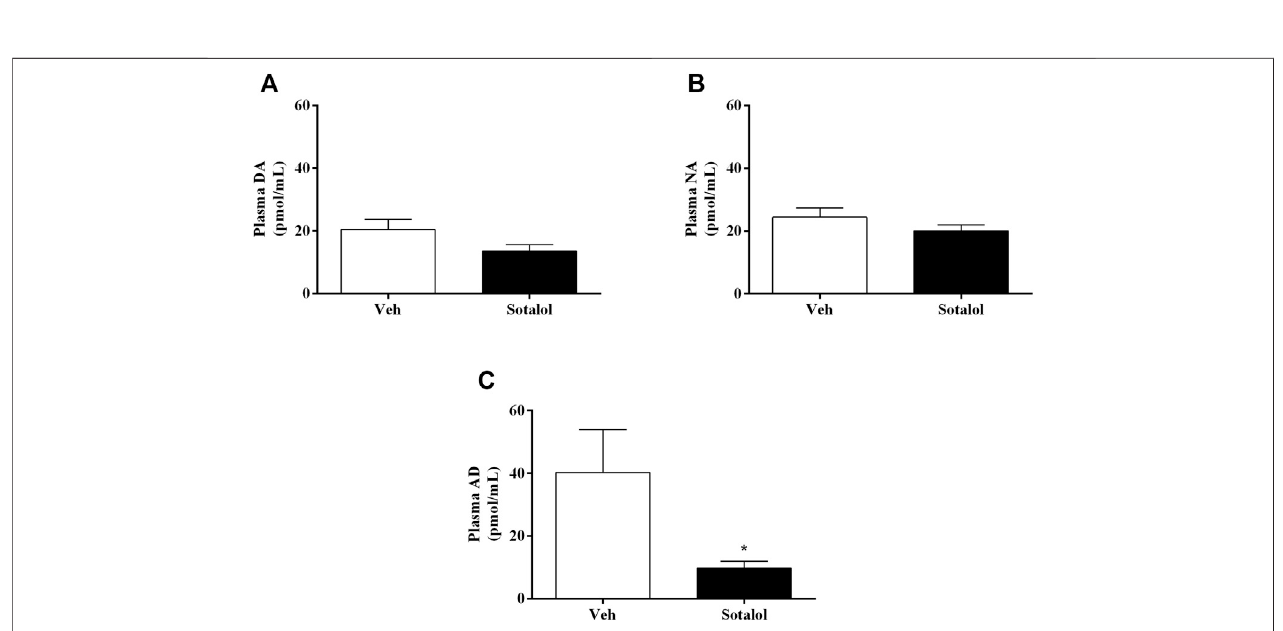
FIGURE6| Concentrationofplasma (A) dopamine (DA), (B) noradrenaline (NA),and (C) adrenaline (AD)after post-traumaticstressdisorder(PTSD)induction (day 14). Values are means ± SEM of 6-7 mice per group. Veh, vehicle-treated PTSD mice; Sotalol, sotalol-treated PTSD mice. *, signi fi cantly different from correspondent values in vehicle-treated PTSD mice ( p ˂